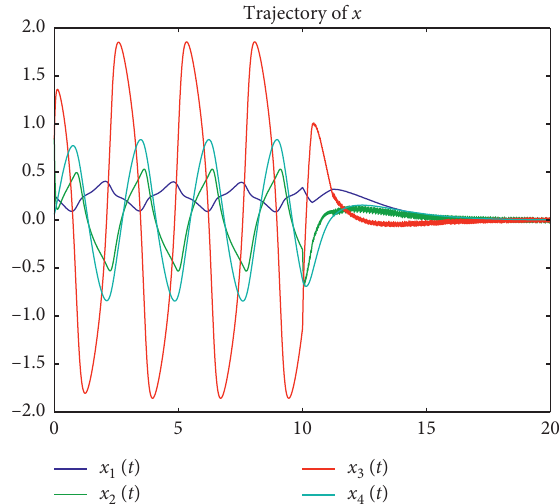
b g ,i � 1 , 2 , 3 , 4 { } , see (10) for the detail ij j 1